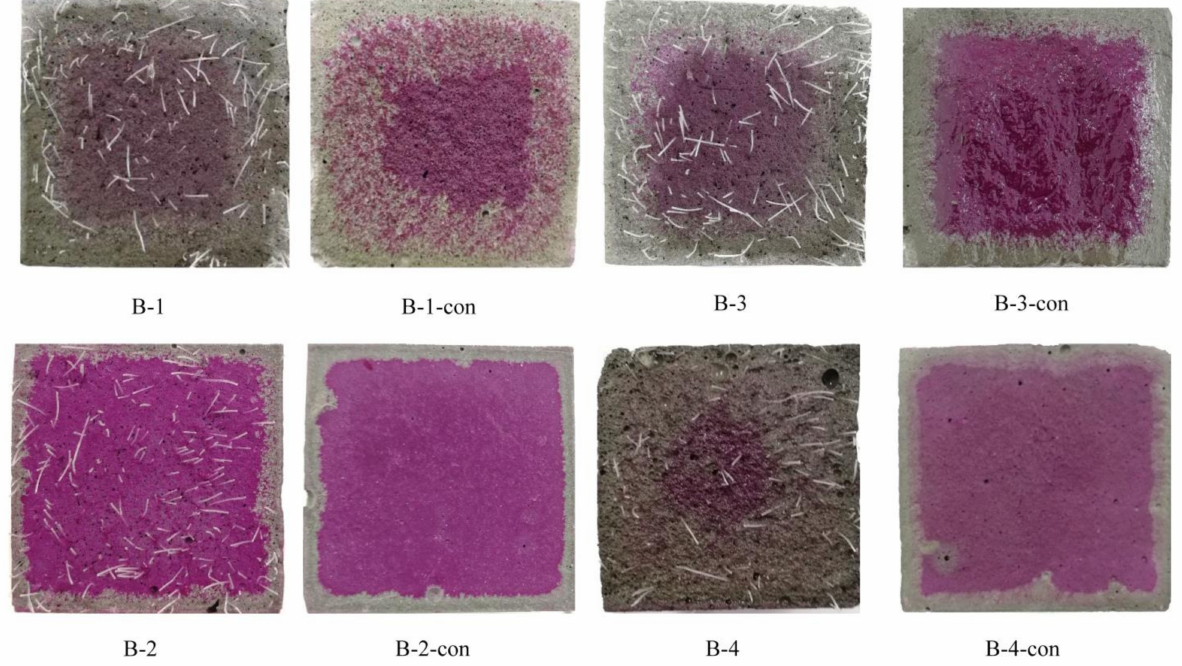
Figure 5. Color changes on fiber-binder composites exposed to early-age carbonation treatment.